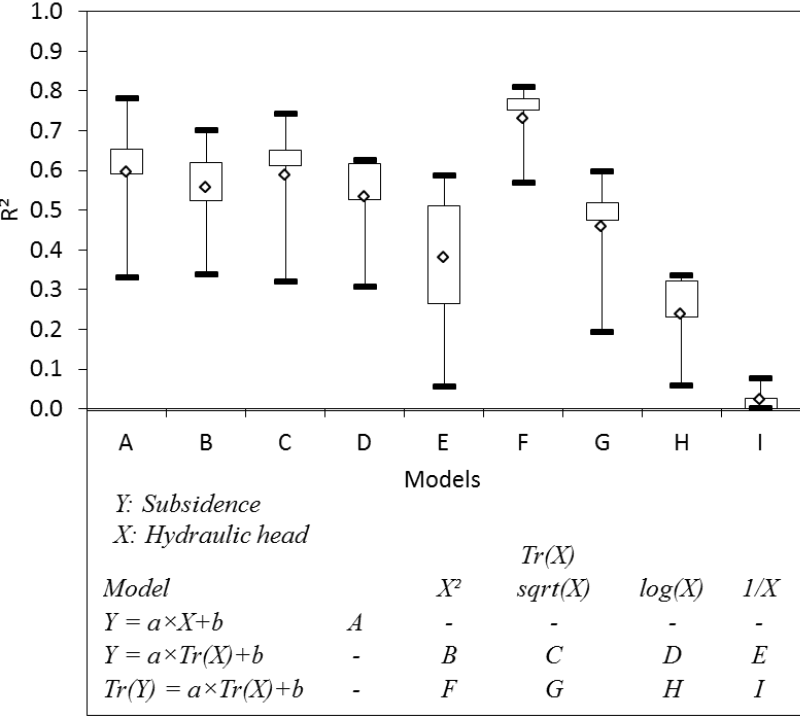
Figure 5. Coefficient of determination (R²) of the tested models for the five considered piezometers .